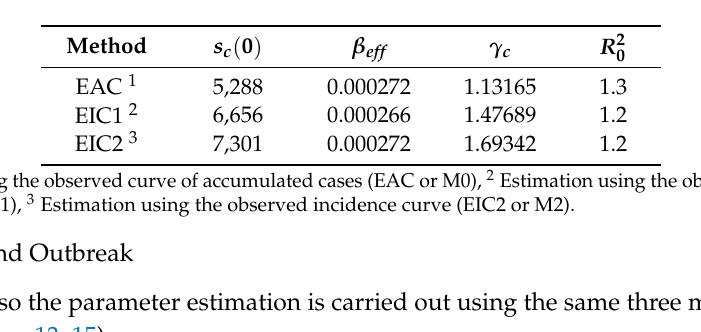
Figure 14. Model fit to the cumulative reported incidence of the second outbreak in Tolima-Colombia using Method 1.